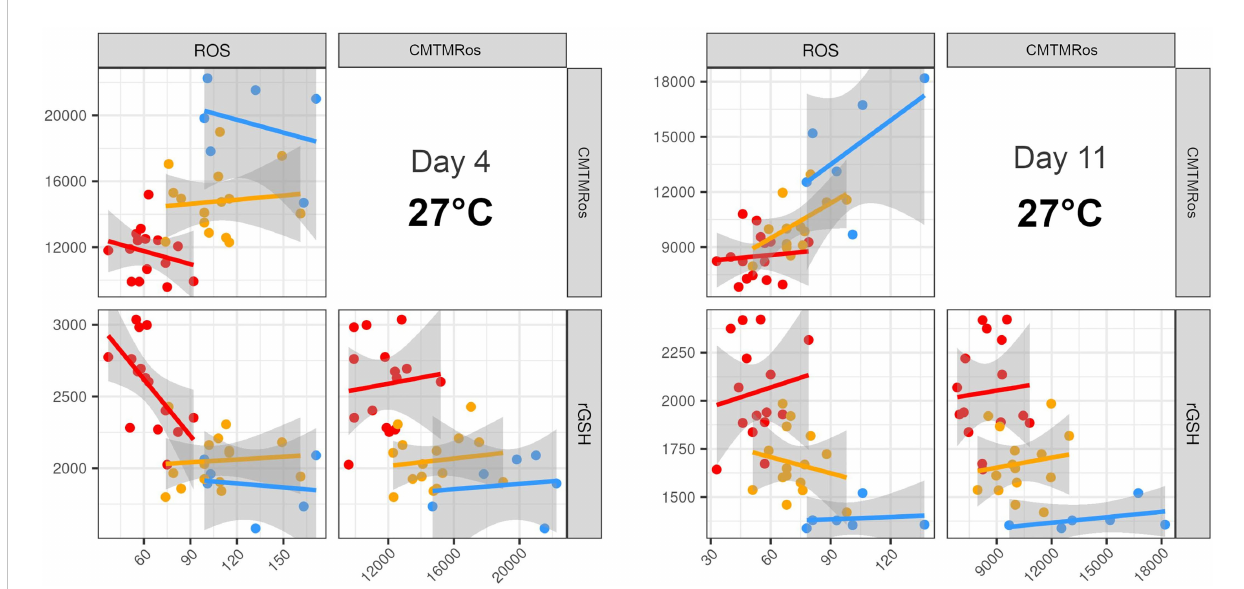
FIGURE 6 Pairwise plots of the three variables that most clearly separate the three strain types. The best resolution was achieved with a combination of ROS, mitochondria activity and rGSH at ambient temperature at Days 4 and 11. WT (blue), SS- (yellow), SS+ (red). Each point on each plot represents a different replicate of the respective strains. Equivalent plots for Days 18 and 28 at each temperature are shown in Figure